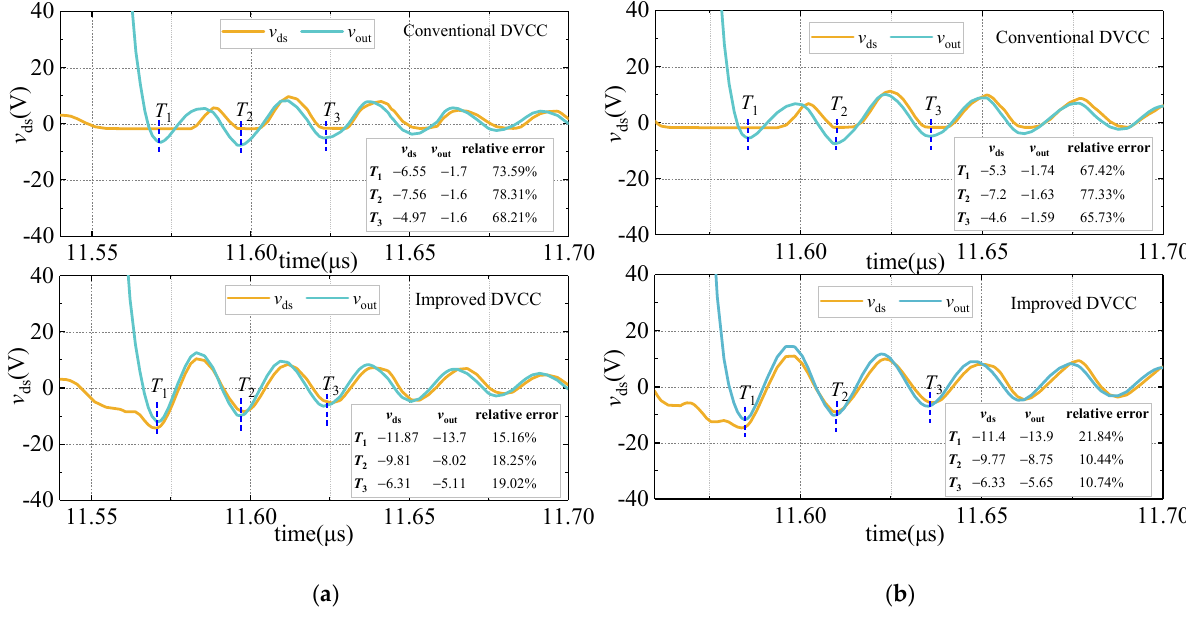
Figure 7. v ds and v out waveform comparison during the on-oscillation state. ( a ) V DC = 400 V; ( b ) V DC = 600 V. The relative error between v ds (actual value) and v out during the on-oscillation state is shown in Figure 7. Compared with the conventional DVCC, the measurement relative error of the improved DVCC is significantly reduced. When V DC is 400 V and 600 V, the